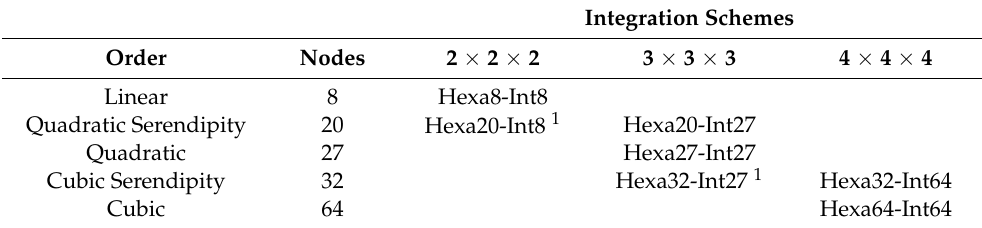
Table 1. Design of